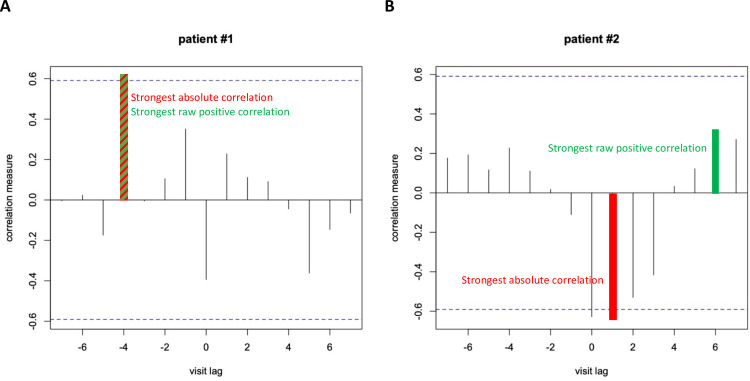
Examples of CCF plots of RA on MS for two patients included in this study.The conventional CCF identified the strongest absolute correlation (tallest overall spike illustrated in red and green stripes the same as the strongest positive correlation) at lag = −4 (panel A) and +1 (panel B). The modified CCF identified the strongest positive correlation (tallest spike above the zero line) at lag = −4 (panel A, in red and green stripes because the same as the strongest absolute correlation) and +6 (panel B, illustrated in green). The dashed blue horizontal lines indicate statistical significance at the p = 0.05 level.